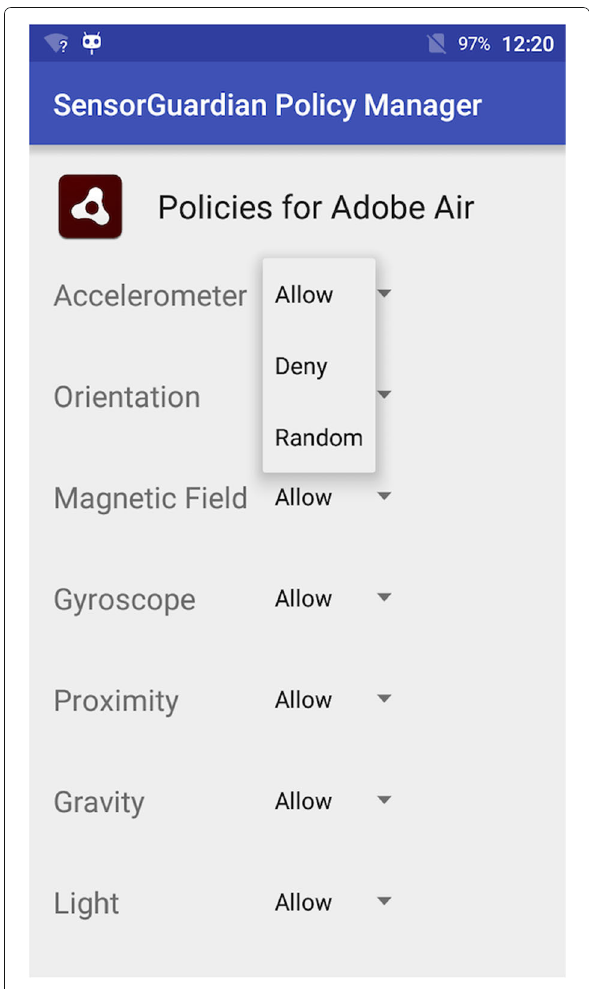
Fig. 3 Screenshot of Policy Manager. A screenshot of Policy Manager’s interactive interface. Sensor Guardian allows the user to decide which app can access what sensors in what ways by providing her this interactive interface for